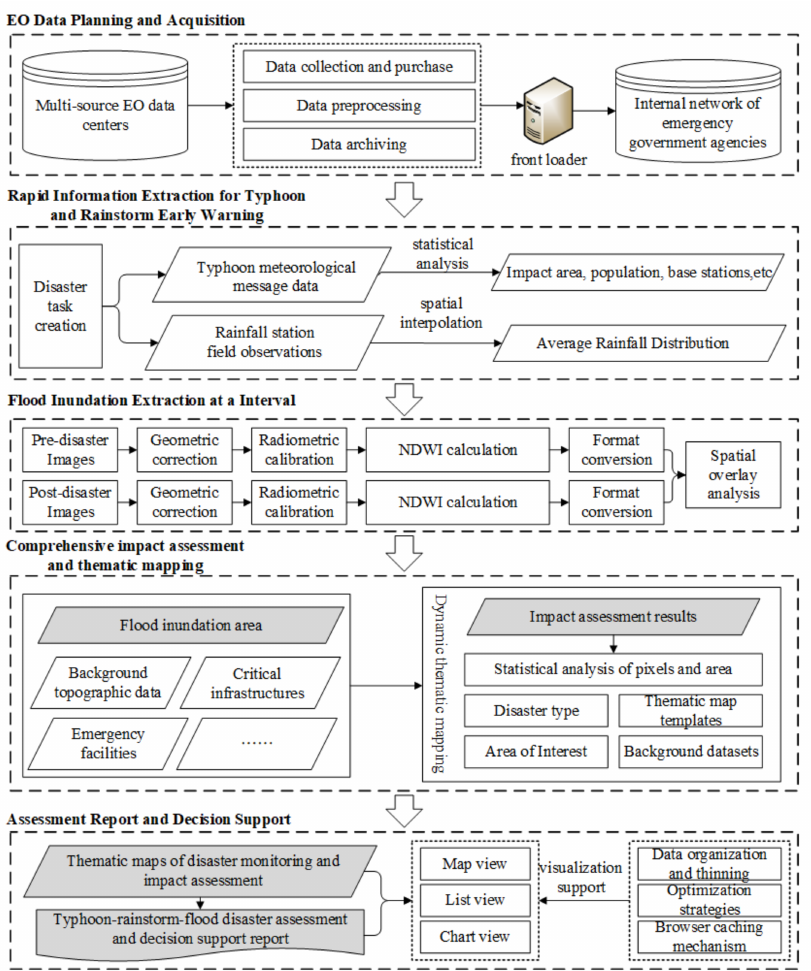
Figure 1. Task-driven emergency response service flow for typhoon-triggered flood